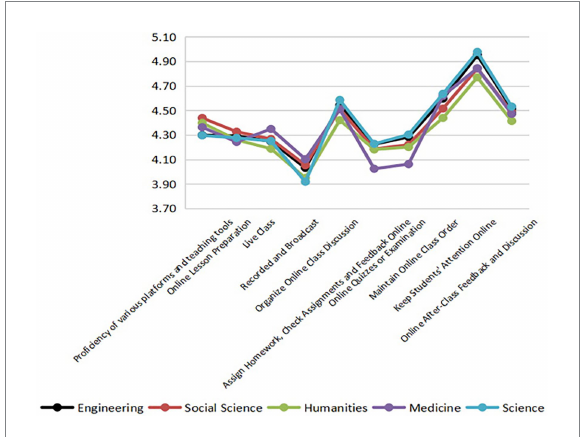
FIGURE 8 Evaluation of the challenges in online education by teachers and students of different